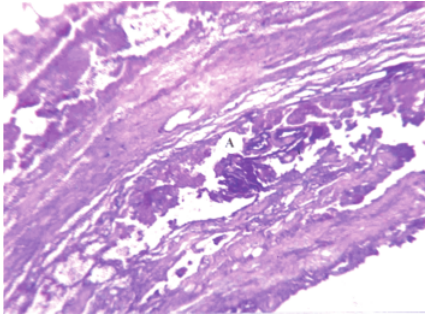
Figure 7: Neural fibers resistant to necrotic changes (A). H&E ( × 100).